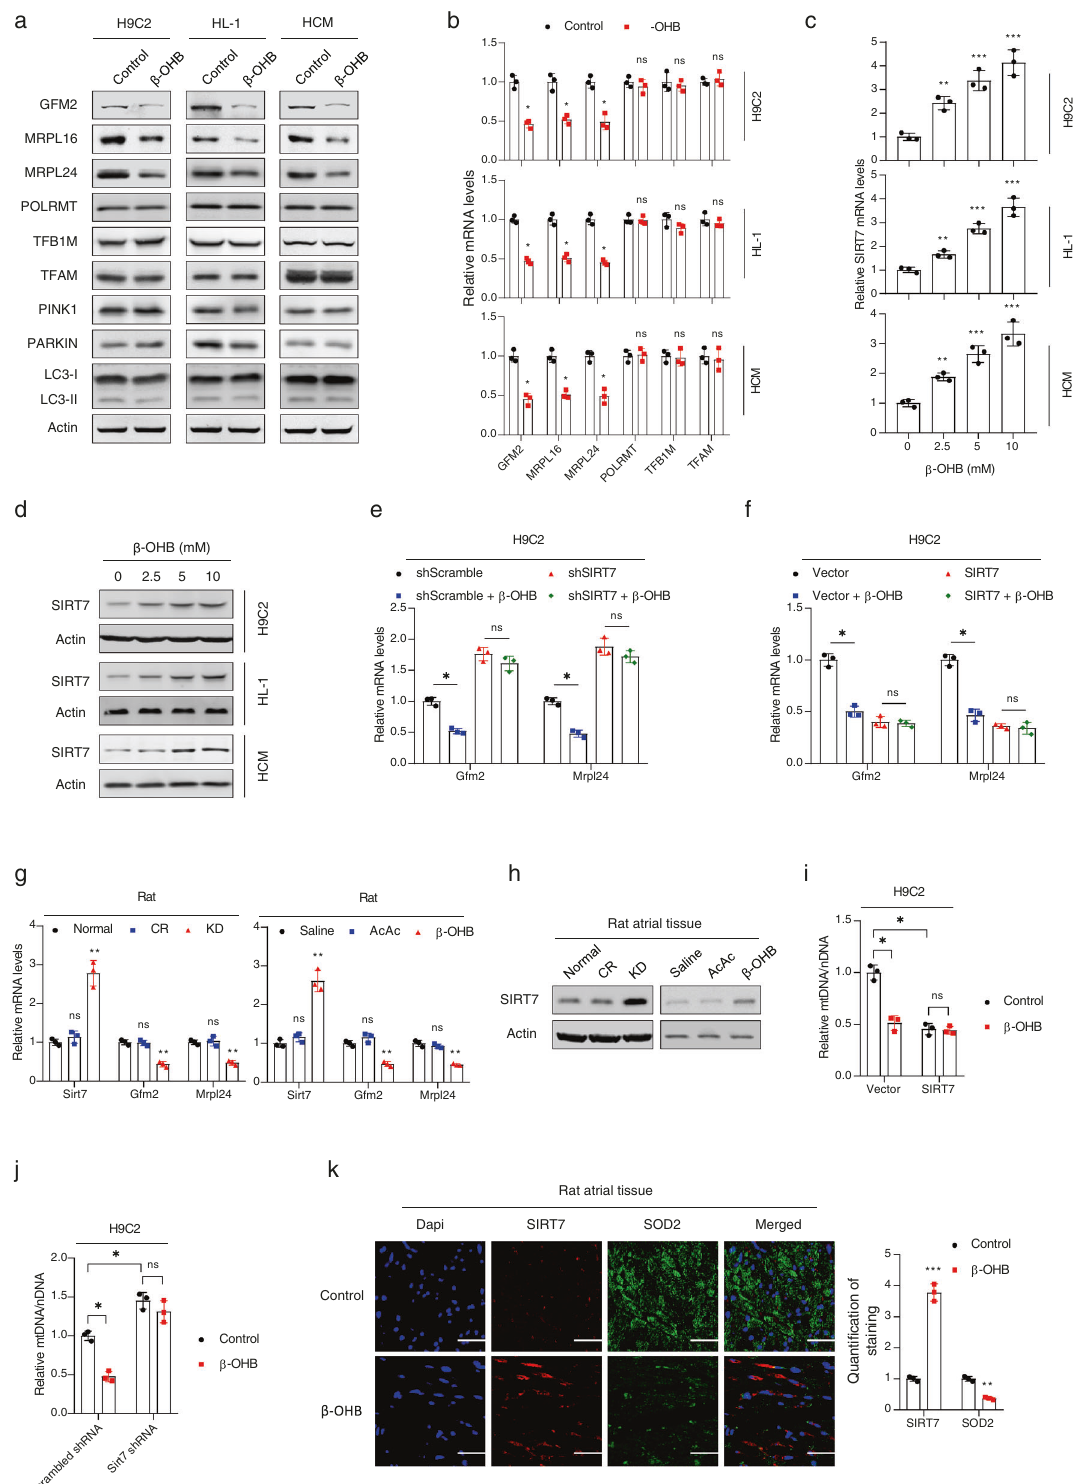
overexpression of SIRT7 decreased mitochondrion levels, whereas knockdown of SIRT7 slightly increased mitochondrion levels in cultured cells (Fig. 4i, j). Either overexpressing or knocking down SIRT7 in cells attenuated the inhibitory effects of β -OHB treatment (Fig. 4i, j). Double immuno fl uorescence staining of atrial tissues from β -OHB-injected or normal rats revealed that β